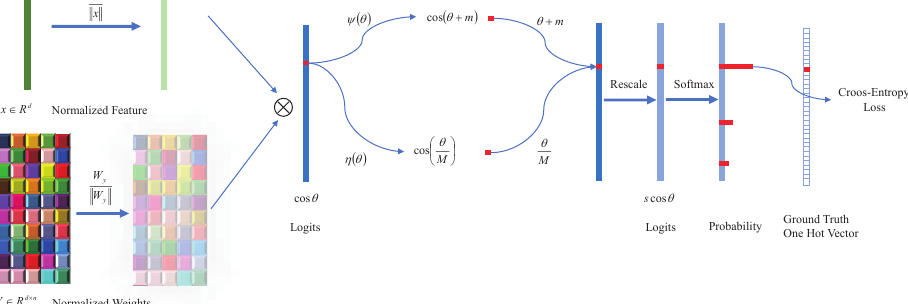
Figure 6. Detailed supervision of DCNN by UnifiedFace loss function. After normalizing the features x and weights W y , we obtain the logit vector cos θ . After that, the angle θ between the weights and the features is obtained. Unlike previous methods, the obtained target angle pinch angle is given an additive margin, i.e., θ + m , and the obtained non-target angle is given a multiplicative margin, i.e., θ . Our approach leads to features learning more compact intra-class similarity and inter-class M separability. Then, all logits are multiplied by the feature scale s . Finally, the logit contributes to the cross-entropy loss through the softmax